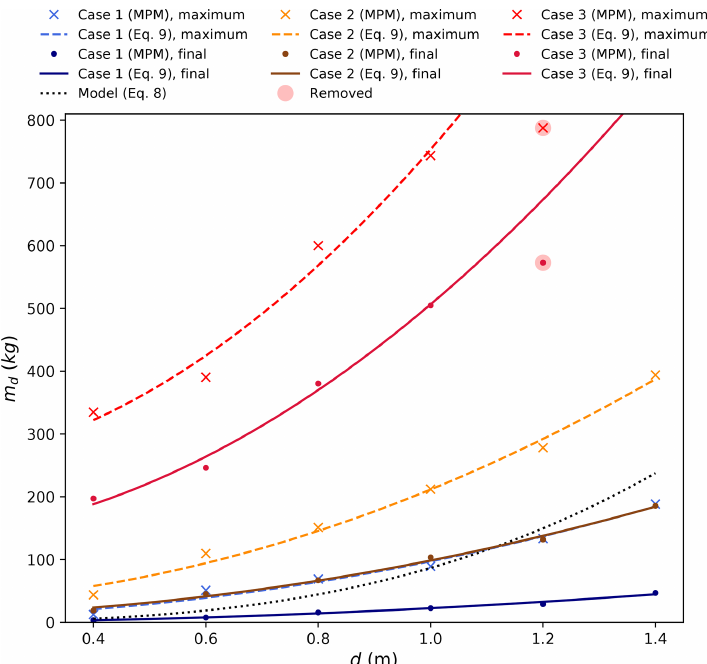
Figure 6. Evolution of the detrainment mass observed for the one-tree arrangement and the fits with the tree diameter for three flow regimes: Case 1, Case 2, and Case 3 with a front velocity of respectively 12.5, 10.9, and 10 . 75ms − 1 . “Maximum” refers to the maximum mass stored behind the tree and “final” refers to the final mass stored. A slope of 30 ◦ and a top wedge angle of 60 ◦ (from measurements Feistl et al., 2014) are used for the theoretical model (Eq. 8). The removed point denotes a special case not considered in the proposed square relation in Eq. (9) since the entire avalanche in this case is stopped due to the low flow velocity and the high tree diameter. Please note that it is a coincidence that Case 1 maximum and Case 2 final agree well.